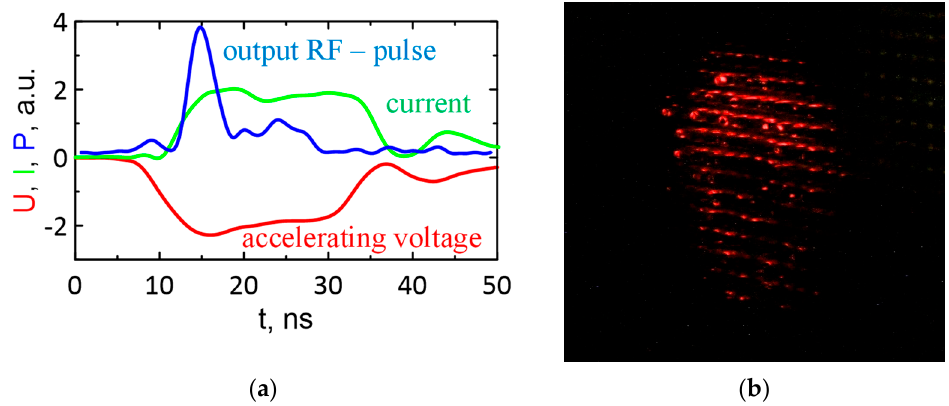
Figure 13. Results of the experimental studies of the Ka-band SWO with 2D DFB based on the “Sinus-6” accelerator: ( a ) typical oscilloscope traces of accelerating voltage (red line), electron beam current (green line), and output RF-pulse (blue line) and ( b ) photograph of glowing neon bulb panel under action of a generated RF-pulse (distance to the output window ~1.5 m).